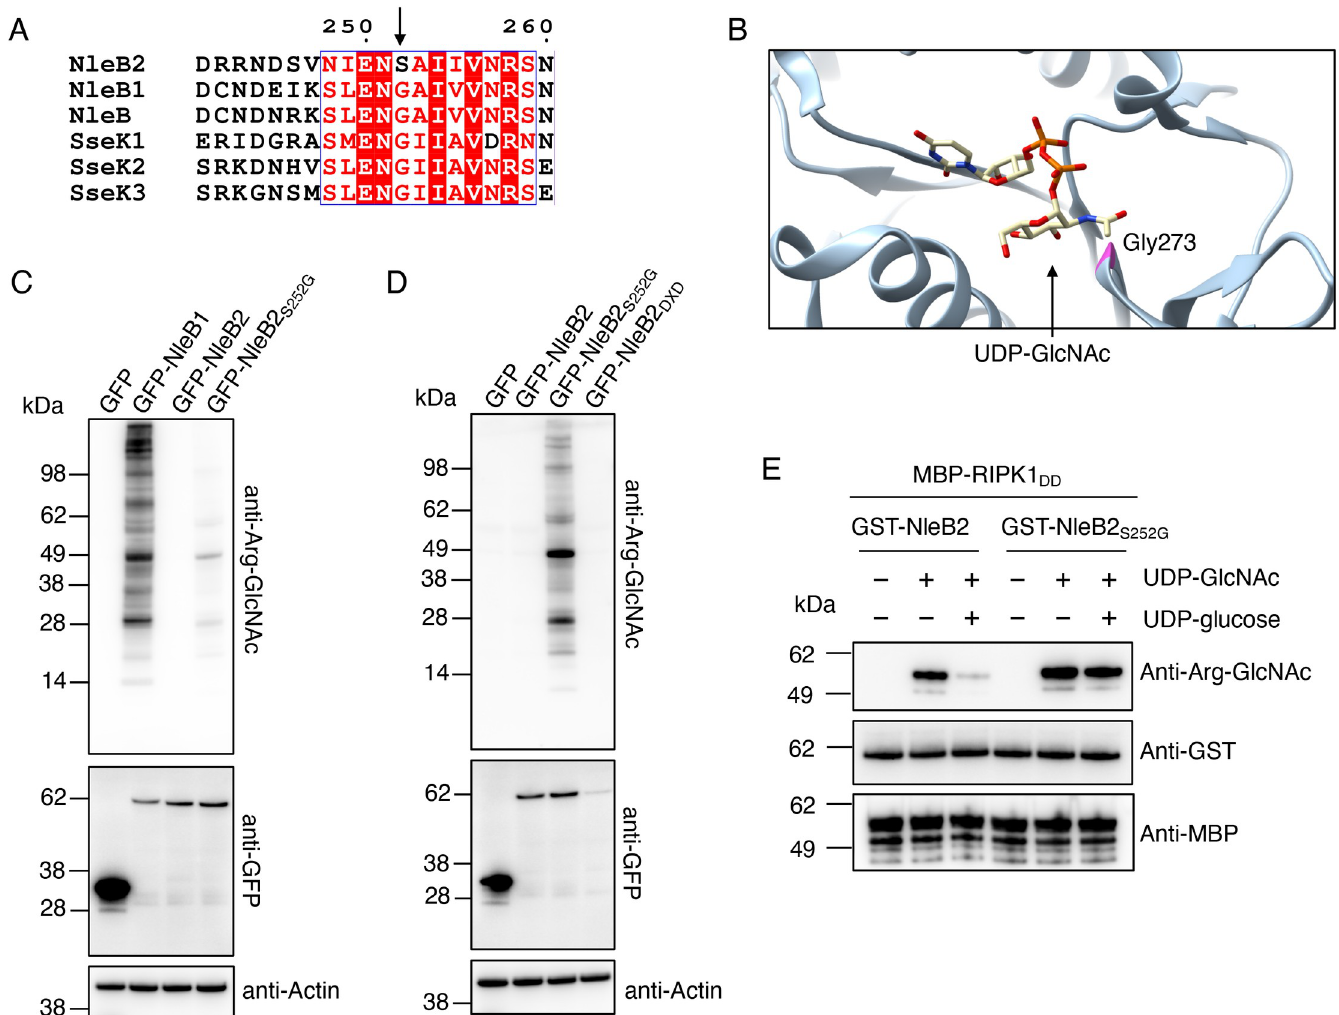
Fig 5. Role of Serine 252 within NleB2 in preference for UDP-glucose. (A) Alignment of NleB2 and NleB1 from EPEC O127:H6 strain E2348/69, NleB from Citrobacter rodentium strain ICC168 and SseK1, SseK2 and SseK3 from Salmonella enterica serovar Typhimurium strain SL1344. Arrow indicates serine 252 within NleB2. Alignment was performed using ClustalW and visualised using ESPript. (B) The crystal structure of SseK2 (PDB ID: 5H63)[18] in complex with UDP-GlcNAc [PMID: 30327479]. The peptide backbone is depicted as a blue ribbon, Glycine 273 is highlighted in pink, and the ligand represented in stick form. The image was generated using Chimera 1.14 with carbon in yellow, nitrogen in blue, oxygen in red and phosphorus in orange. (C) HEK293T cells were transfected with either pEGFP-C2, pGFP-NleB1, pGFP-NleB2 or pGFP-NleB2 S252G before being lysed and subjected to PAGE and immunoblot with anti-Arg-GlcNAc and anti-GFP antibodies. Anti-Actin antibodies were used as a loading control. Representative immunoblots of at least 3 independent experiments. (D) HEK293T cells were transfected with either pEGFP-C2, pGFP-NleB2, pGFP-NleB2 S252G or pGFP-NleB2 DXD before being lysed and subjected to PAGE and immunoblot with anti-Arg- GlcNAc and anti-GFP antibodies. Anti-Actin antibodies were used as a loading control. Representative immunoblots of at least 3 independent experiments. (E) In vitro sugar donor competition assays. MBP-RIPK1 DD was incubated with GST-NleB2 or GST-NleB2 S252G either without sugar donors, or in the presence of 25 μ M UDP-GlcNAc alone or in combination with 25 μ M UDP-glucose. Proteins were subjected to PAGE and immunoblot with anti-ArgGlcNAc, or anti-MBP and anti-GST antibodies as controls. Representative of at least 3